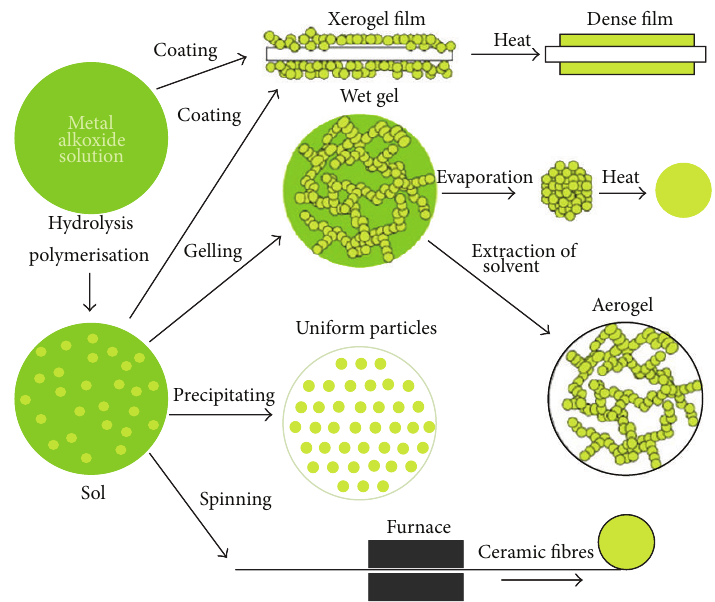
Figure 12: Schematic of sol-gel procedure and their products